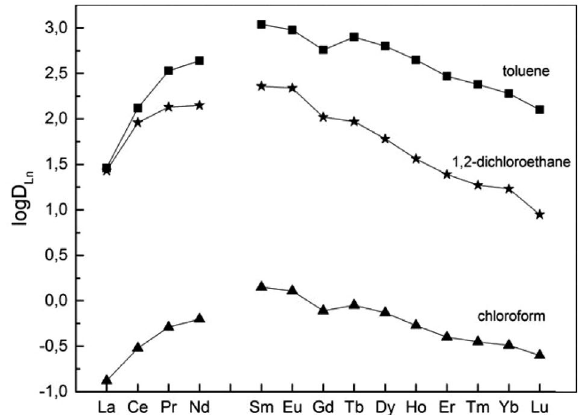
mixtures in toluene, 1,2-dichloroethane and chloroform at [HP] = 0.02 M, [L] = 0.005 M and pH = 2.0.